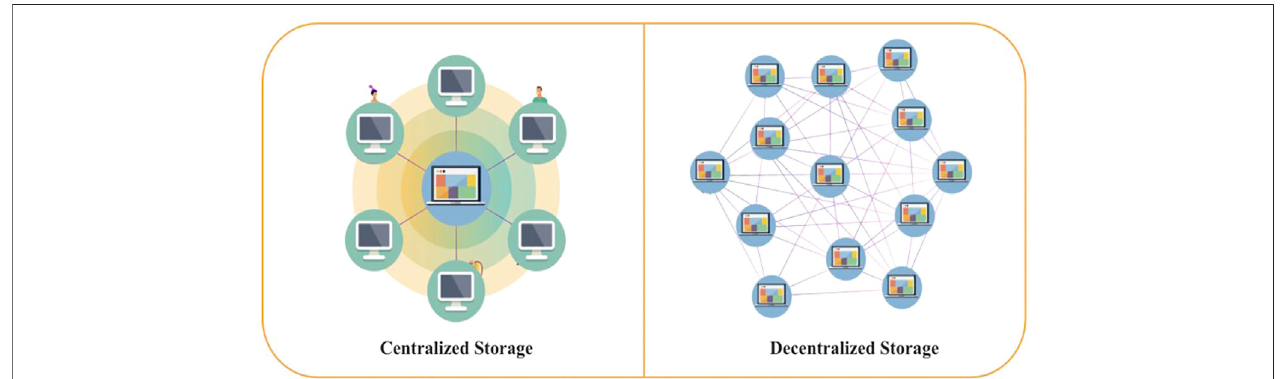
FIGURE 1 | Centralized Storage vs. Decentralized